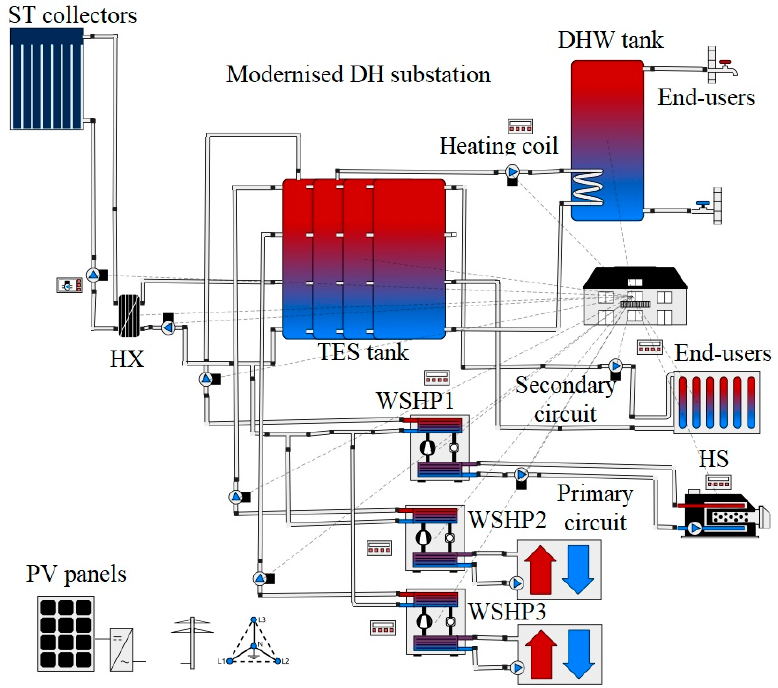
Figure 12. Schematic diagram of modernised “UMT” district heating (DH) substation. In order to cover the electricity consumption of the three SWHPs, 2000 PV pan- els of the type AXIpremium XXL HC with a total capacity of 1090 kW, which produce 1160 MWh/year of AC with an energy efficiency of 72.3%, are installed on an area of 5160 m 2 of the available terraces of the buildings supplied by DH